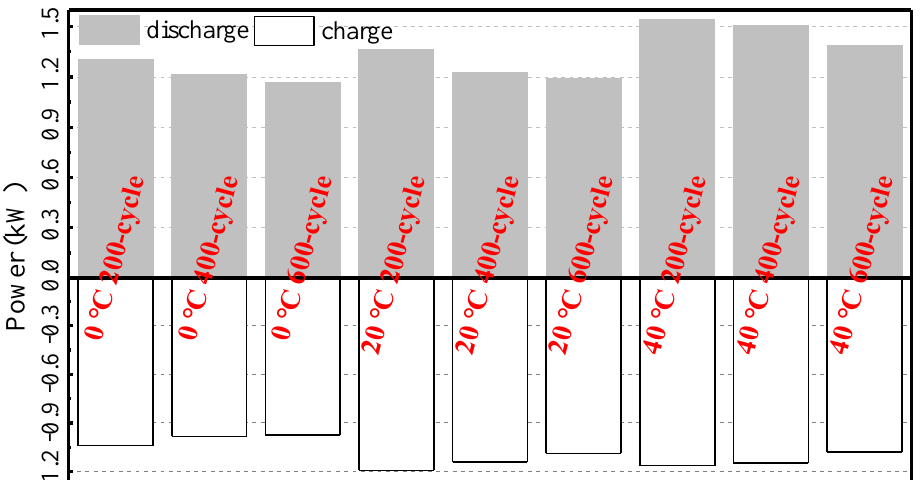
Figure 7. Average charging and discharging SoPs at temperatures of 0, 20 and 40 °C, and aging levels of 200, 400, and 600 cycles.